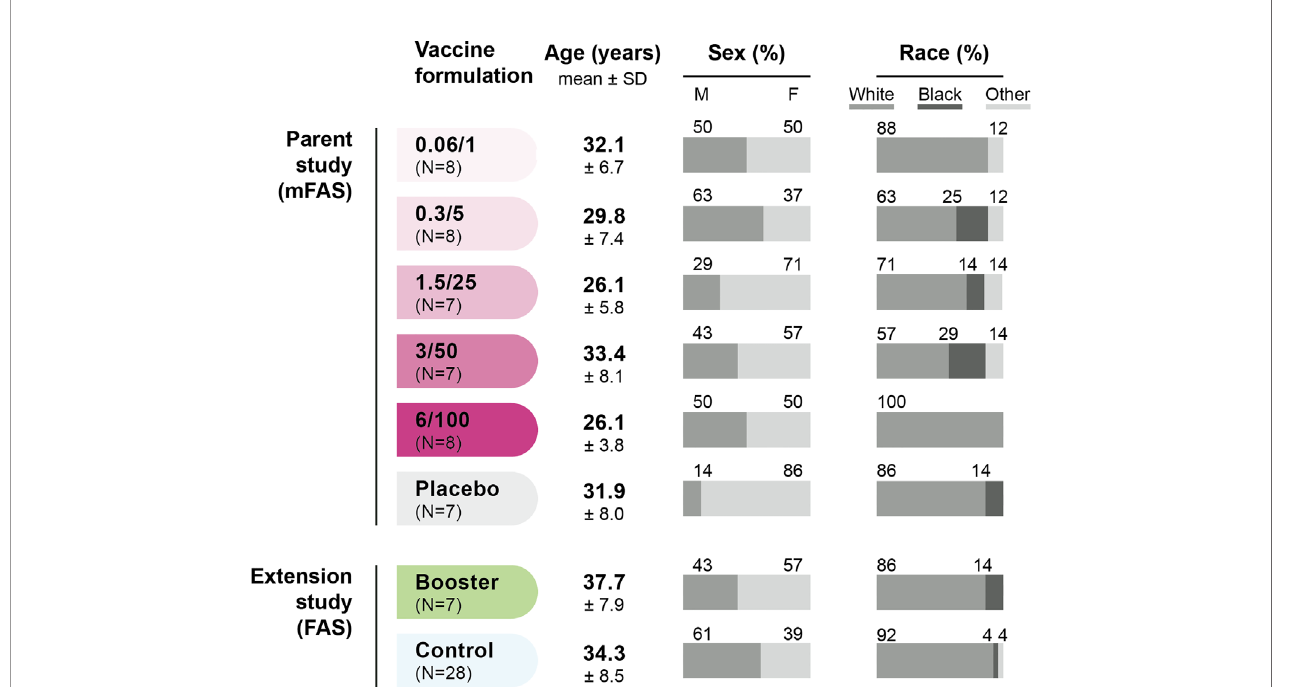
FIGURE 2 | Demographic characteristics of participants. FAS, full analysis set; mFAS, modi fi ed FAS; SD, standard deviation; N, number of participants; 0.06/1, group receiving 1790GAHB formulation with 0.06 µg O antigen (OAg) and 1 µg protein; 0.3/5, group receiving 1790GAHB formulation with 0.3 µg OAg and 5 µg protein; 1.5/25, group receiving 1790GAHB formulation with 1.5 µg OAg and 25 µg protein; 3/50, group receiving 1790GAHB formulation with 3 µg OAg and 50 µg protein; 6/100, group receiving 1790GAHB formulation with 6 µg OAg and 100 µg protein; Placebo, group receiving placebo; Booster, group receiving a booster 1790GAHB dose (1.5/25 µg OAg/protein) 2 – 3 years after primary vaccination; Control, placebo recipients (from the parent study) and vaccine-naïve participants (newly enrolled in the extension study) receiving one dose of 1790GAHB (1.5/25 µg